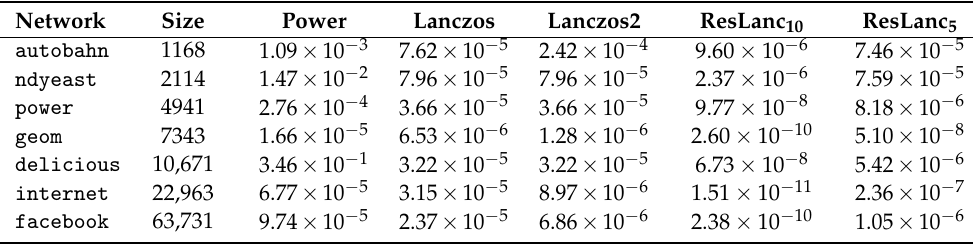
Table 3. Errors produced by the methods with respect to the Perron vector computed by the eigs function of